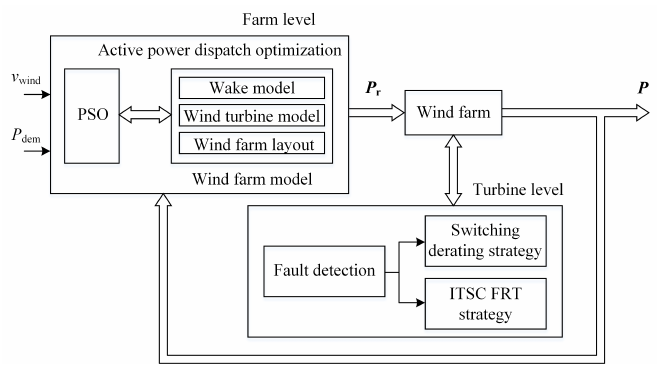
Figure 8. Control diagram of power dispatch.